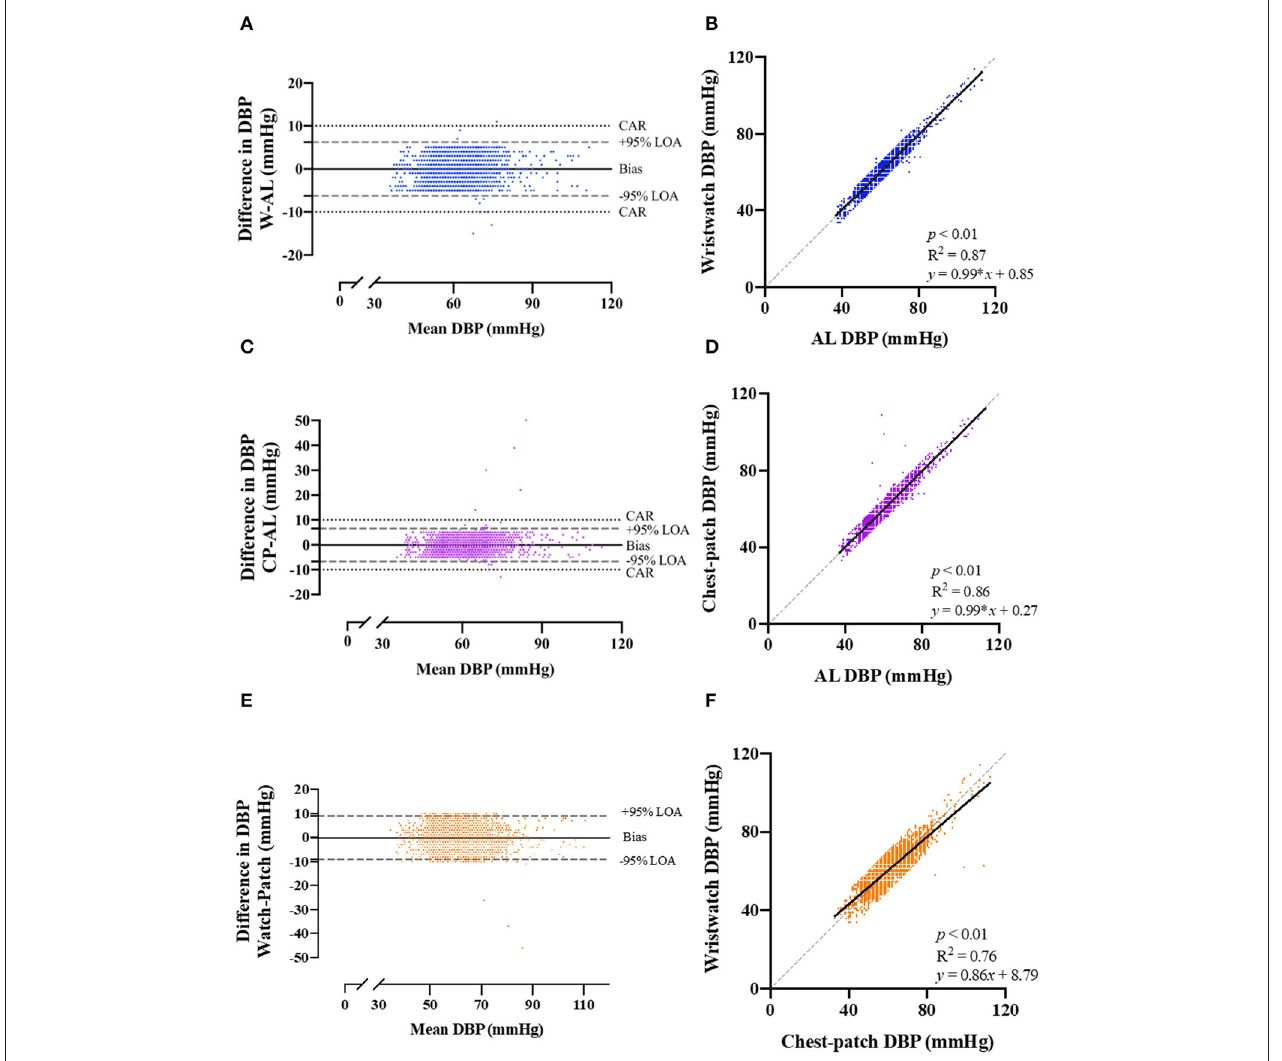
FIGURE 3 | Bland-Altman plots of the relationship and limits of agreement between the photoplethysmography-based devices’ non-invasive diastolic blood pressure measurements and the arterial line’s invasive measurements. Bland-Altman plots (left panels) and Pearson’s correlations (right panels) are shown for wristwatch and arterial line (A,B) , chest-patch and arterial line (C,D) , and wristwatch and chest-patch (E,F) . In the right panels, the solid line is the best fit linear regression and the dash line is the line of identity. In the left panels, the solid horizontal line represents the mean difference between the two measurements (bias), the dash horizontal lines represent the 95% limits of agreement (LOA), and the dotted lines represent the clinically accepted range (CAR). W, wristwatch configuration; CP, chest patch configuration; DBP, diastolic blood pressure; AL, arterial